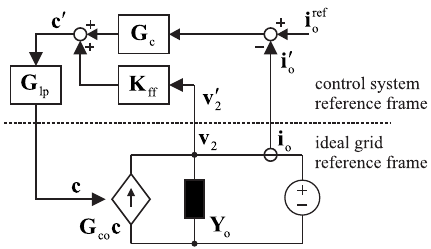
Figure 11. Equivalent small-signal circuit with control